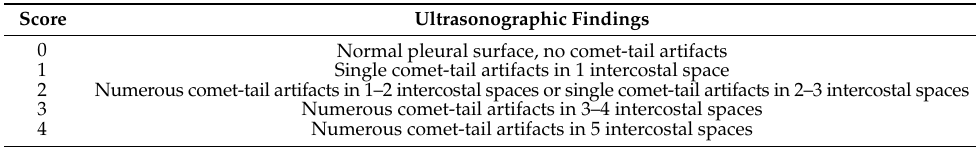
Table 1. Thoracic ultrasonography scoring system. Adapted from Siwinska et al., 2019 [19]. Score 0 Normal pleural surface, no comet-tail artifacts